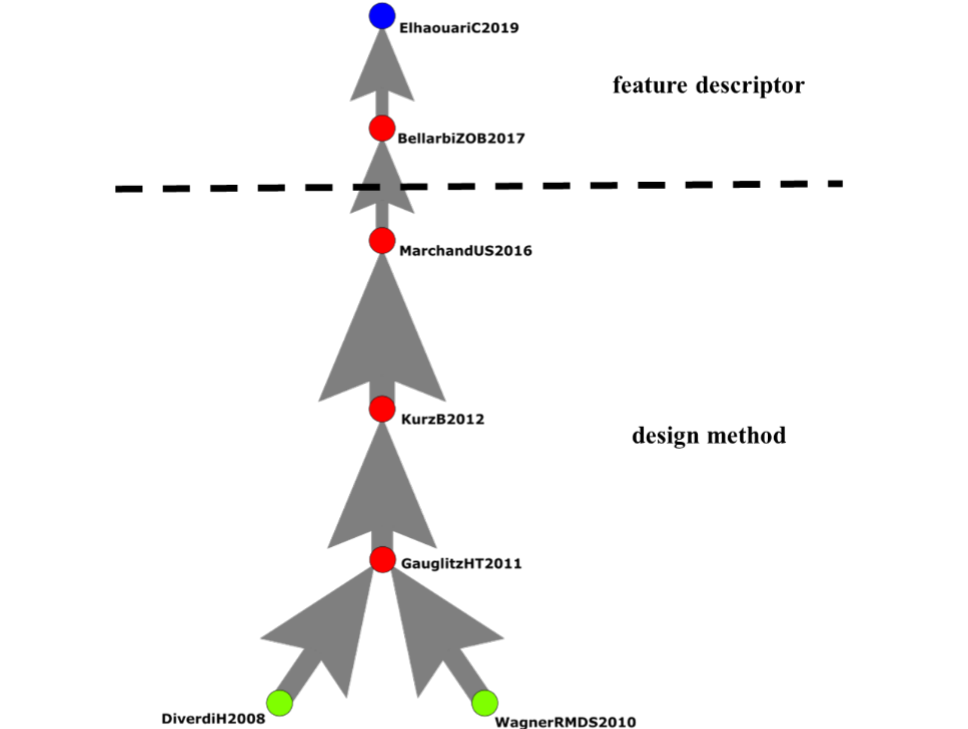
Figure 10. Application of AR technology in visual tracking.